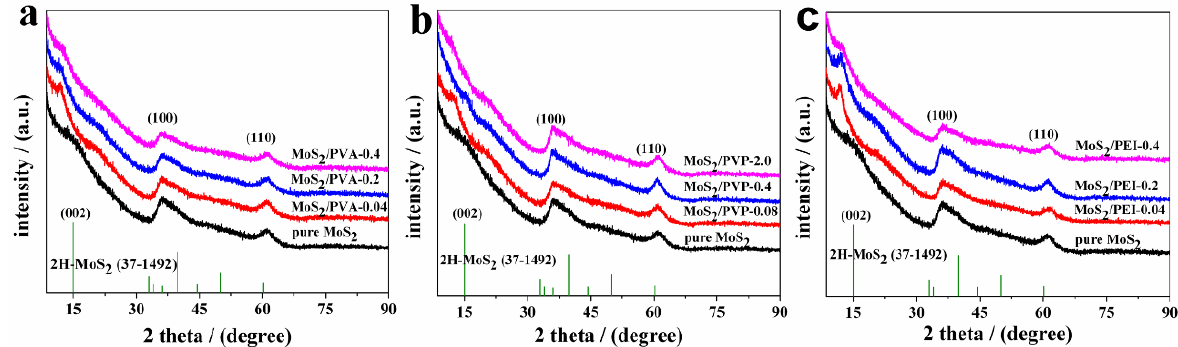
Figure 1. X-ray diffraction (XRD spectra of the as-prepared MoS 2 -based nanoflower-like catalysts: ( a ) MoS 2 /polyvinyl alcohol (PVA) composite; ( b ) MoS 2 /polyvinylpyrrolidone (PVP) composite; ( c ) MoS 2 /polyethylenimine (PEI) composite.